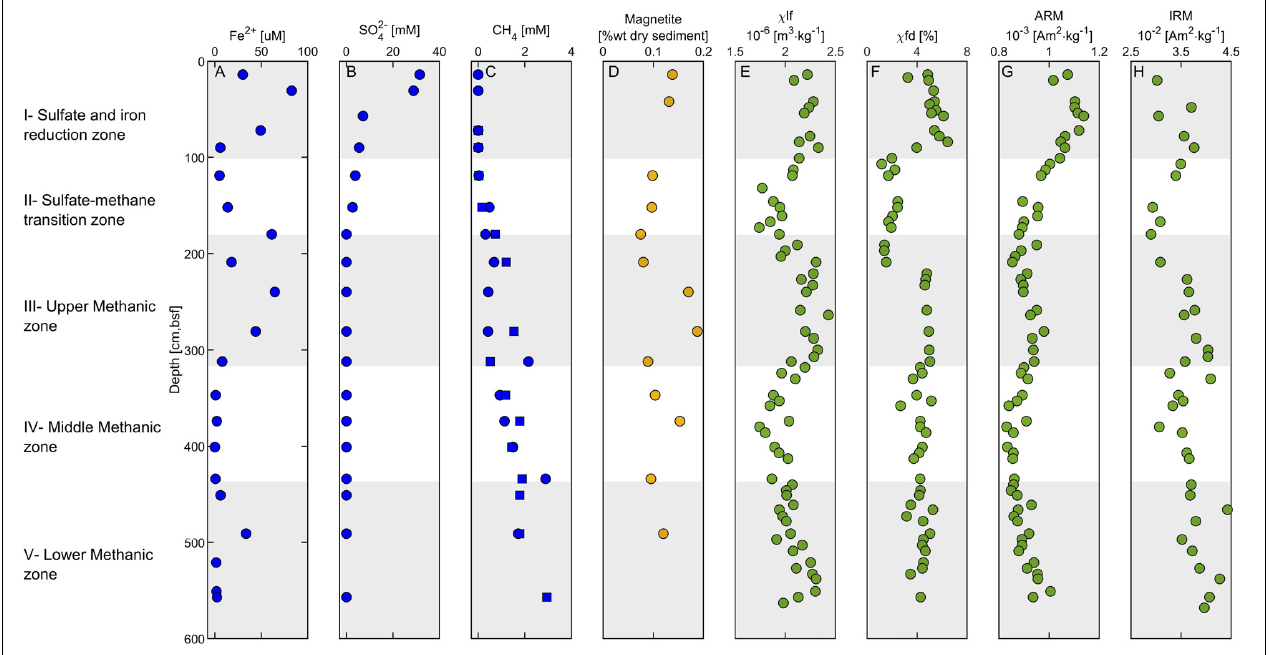
FIGURE 6 | Geochemical – magnetic depth profiles. (A) Porewater ferrous iron concentrations. (B) Porewater sulfate concentrations. (C) Porewater methane concentrations. (D) sediment magnetite concentration [following extractions of Poulton and Canfield (2005) protocol]. (E) Low-frequency susceptibility, (F) Frequency dependent susceptibility. (G) Anhysteretic remanent magnetization (ARM). (H) Isothermal remanent magnetization (IRM). The data in panels (A–C) represent the average of duplicates with error values smaller than the sample symbol, except the methane profile, in which the two duplicates are shown (in squares and circles). The five diagenetic zones are marked with white and gray